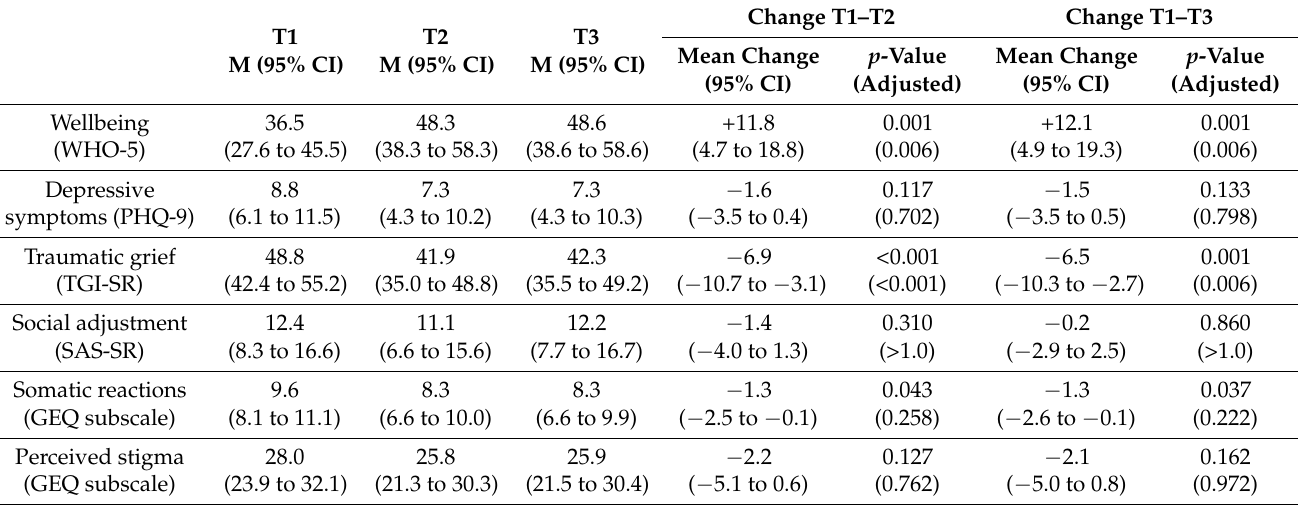
Table 3. Change in outcome measures at three-month (T2) and six-month (T3) follow-up.